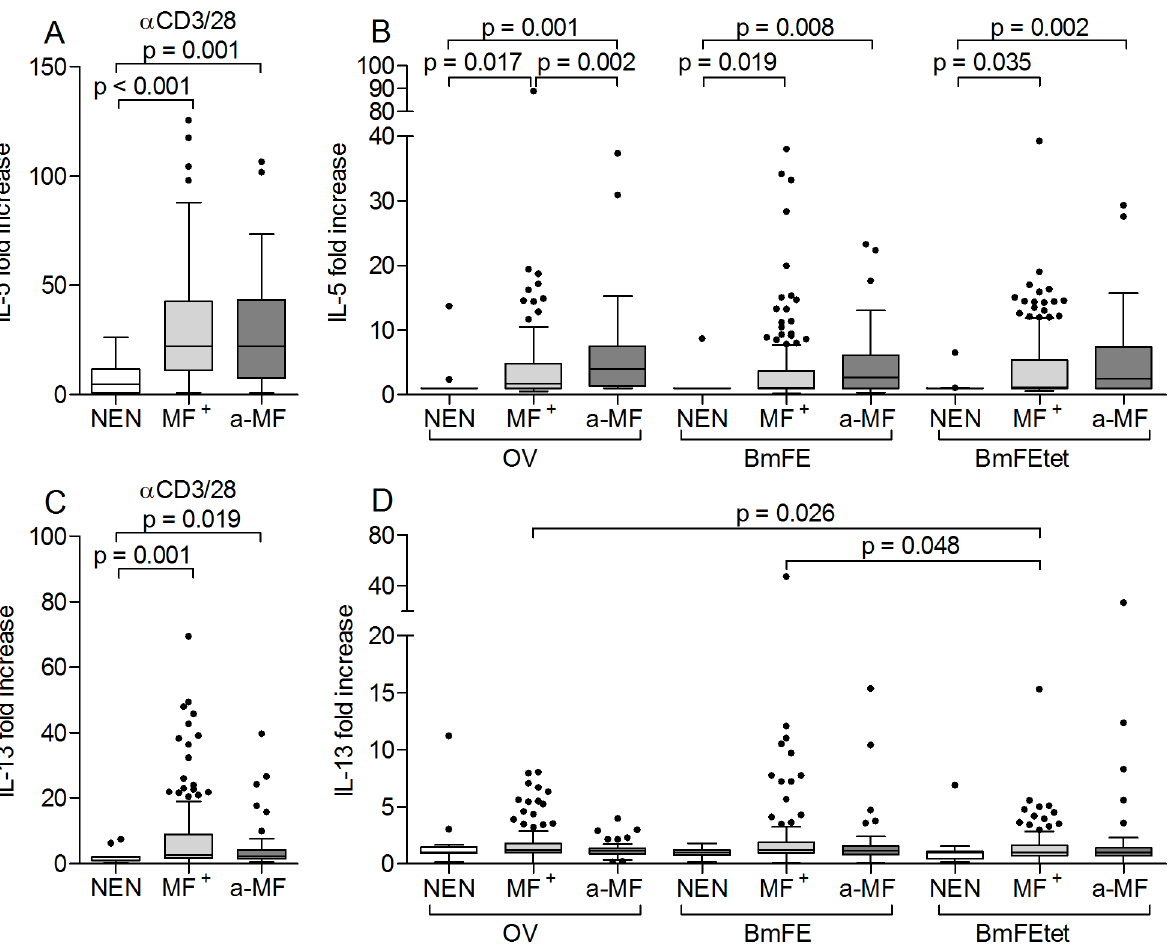
Figure 4. Elevated filarial-specific IL-5 production is associated with MF status. Isolated PBMCs (2 6 10 5 /well) from NEN or O. volvulus infected MF + or a-MF patients were stimulated with either anti-CD3/anti-CD28 (10 m g/ml/2.5 m g/ml) (A and C), an O. volvulus extract (OV, 5 m g/ml), a B. malayi female extract (BmFE, 5 m g/ml) or an extract from B. malayi females worms from infected animals that were depleted of Wolbachia through tetracycline treatment (BmFEtet, 5 m g/ml) (B and D) for 72 hours. Thereafter, levels of IL-5 (A and B) and IL-13 (C and D) were measured in the culture supernatants via ELISA. Data are plotted as fold increase over unstimulated controls. Graphs show box whiskers with median, interquartile ranges and outliers. Statistical significances between the indicated groups were obtained after Kruskal-Wallis and Mann-Whitney